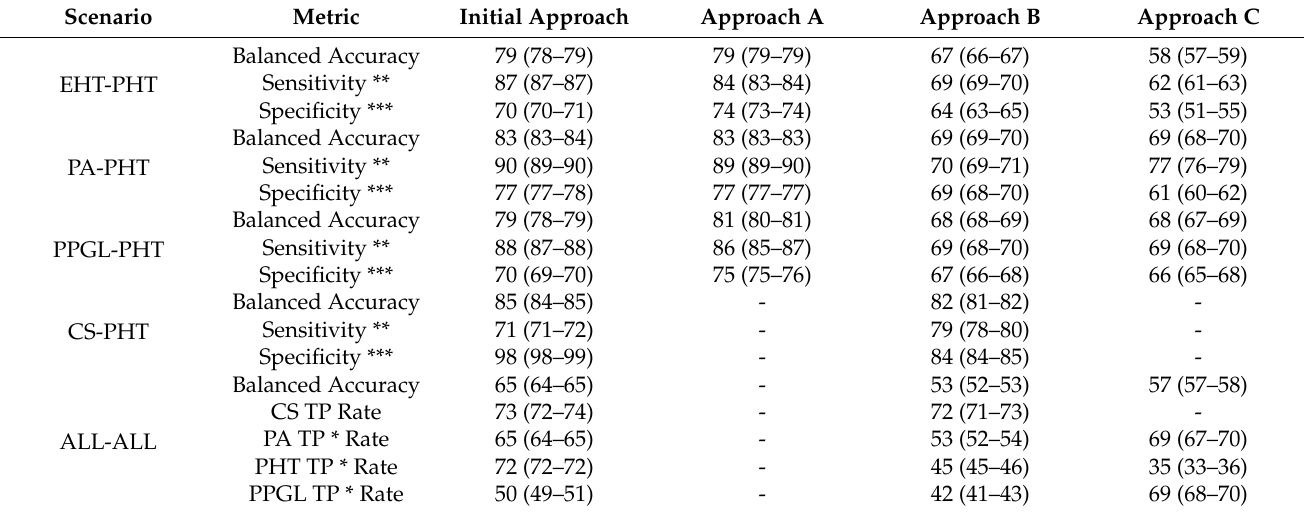
Table 2. Summary of accuracies from sPLSDA models via each approach for each scenario.